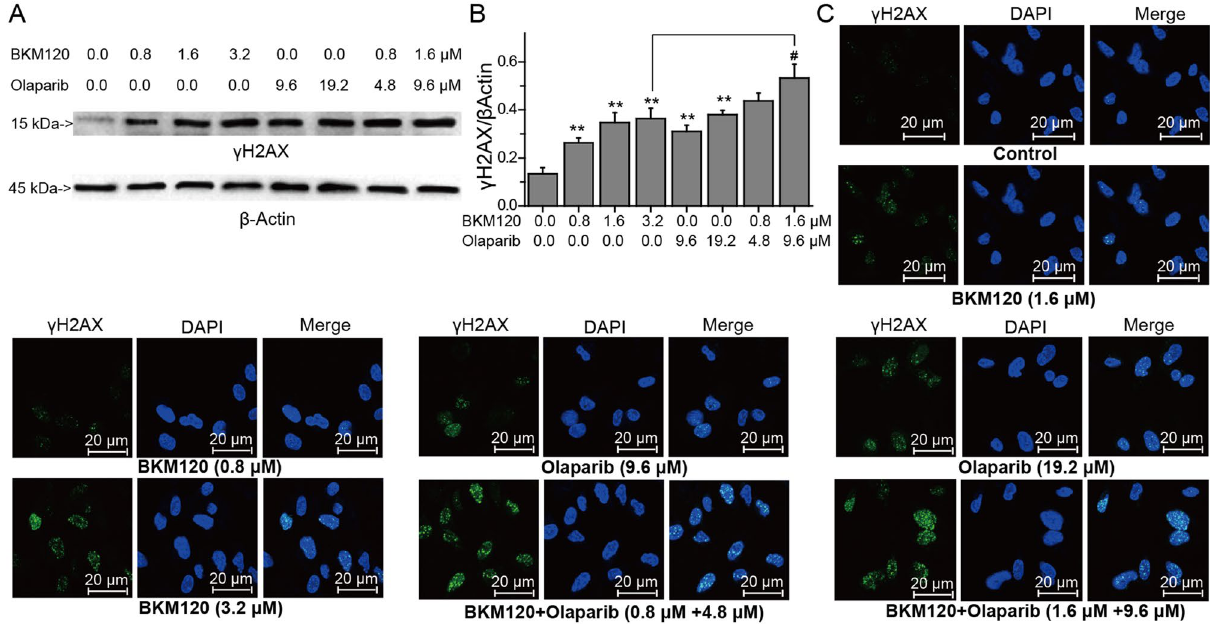
Figure 3. Synergistic effects of BKM120 and Olaparib on the expression of γh2AX. ( A ) Effects of BKM120, olaparib, and their combination on the expressions of γh2AX analyzed by western blots. ( B ) Relative intensity expression obtained from Western blots. ( C ) Effects of drugs on the expression of γh2AX analyzed by Immunofluorescence. Green represents the MDA-MB-231 cells stained with anti-γh2AX antibody, Blue represents the nuclei stained with DAPI. Error bars represent SEM from the mean of three separate experiments. * P < 0.05 and ** P < 0.01 compared to control, # P < 0.05 and ## P < 0.01 compared to 3.2 μM BMK120-treated